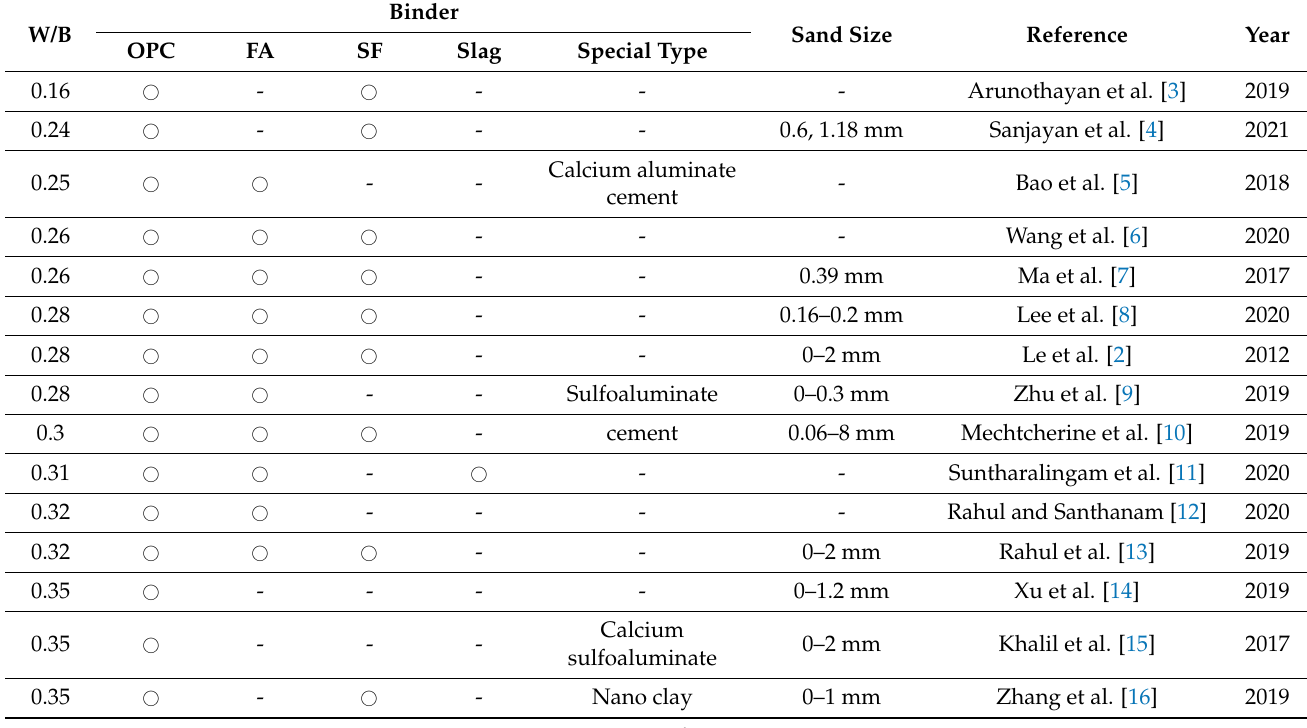
Table 1. Mix type for 3D printing used previous